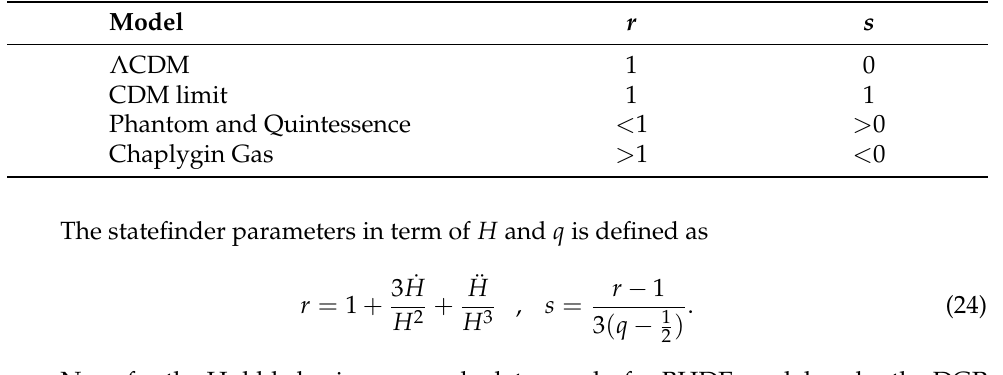
Table 2. The different DE models corresponding to different values of r and s